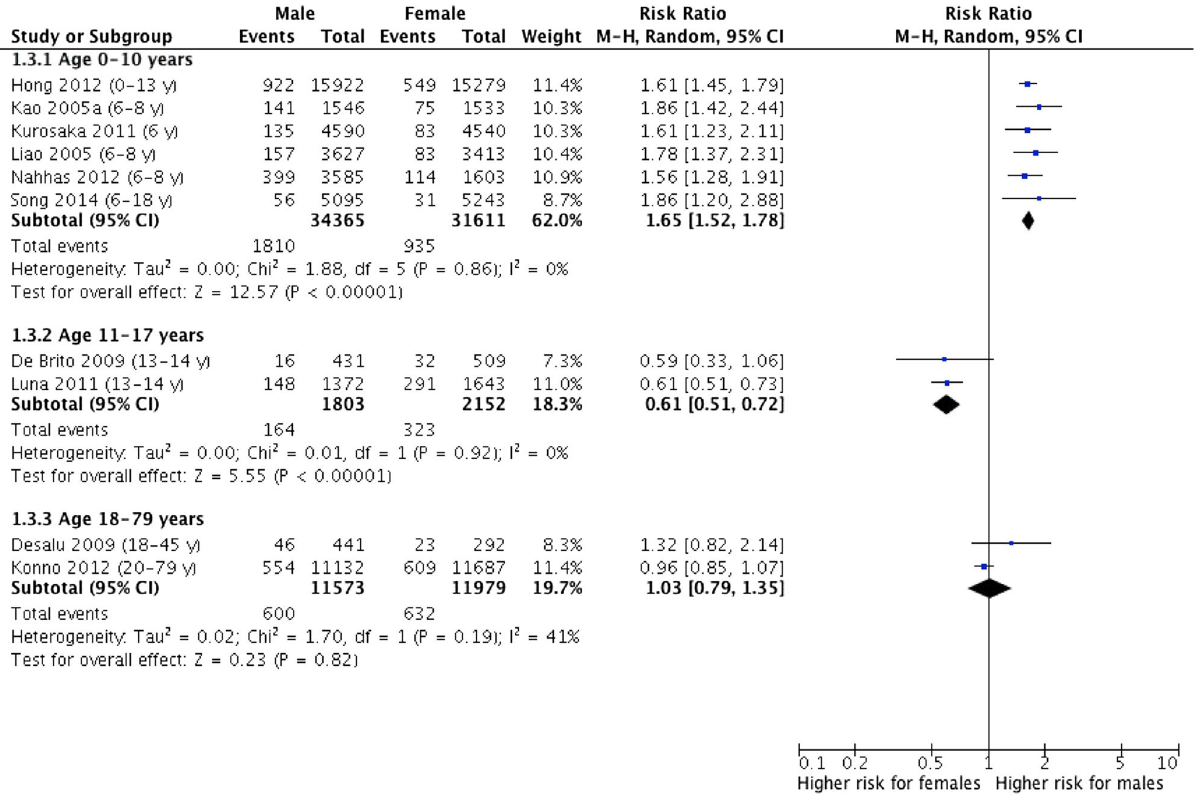
Fig. 2 Forest plot estimating the difference in prevalence of current coexisting allergic rhinitis and asthma between males and females in child- hood, adolescence and